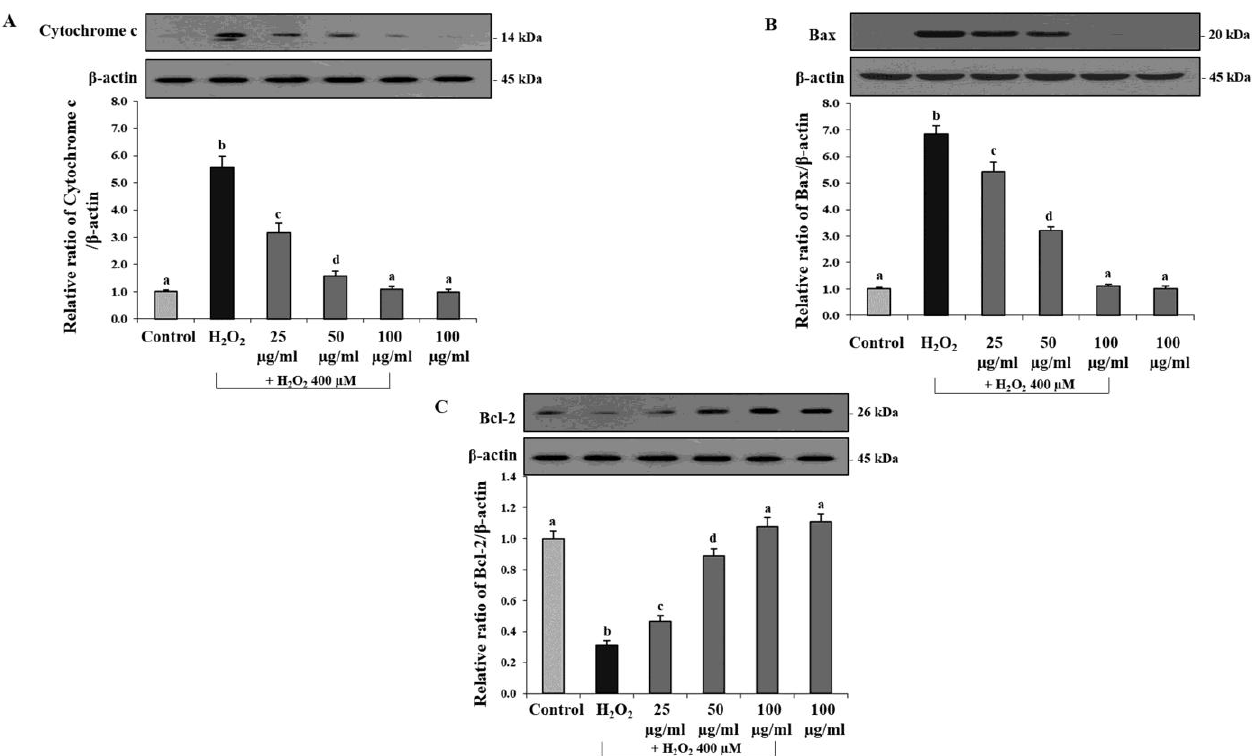
Figure 8. Evaluation of the effect of compound 3 on apoptosis protein expression in oxidative-stress- induced ARPE-19 cells. Cells were pre-treated with compound 3 at 25, 50 and 100 µg/mL for 24 h, followed by incubation with 400 µM H 2 O 2 for 60 min. Protein levels of ( A ) cytochrome c, ( B ) Bax, and ( C ) Bcl2 were examined by immunoblotting. Band densitometry values of cytochrome c, Bax and Bcl-2 were normalized to the band of β -actin. Results are expressed as mean ± SD values ( n = 4). Different superscript letters (a–d) indicate significant differences between values in the column ( p < 0.05).